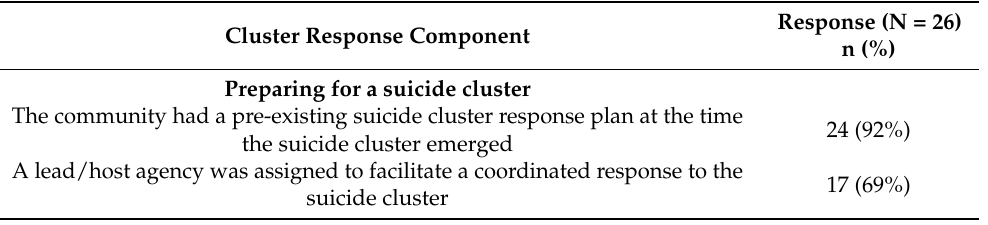
Table 2. Results of the stakeholder survey based on the core components of cluster response